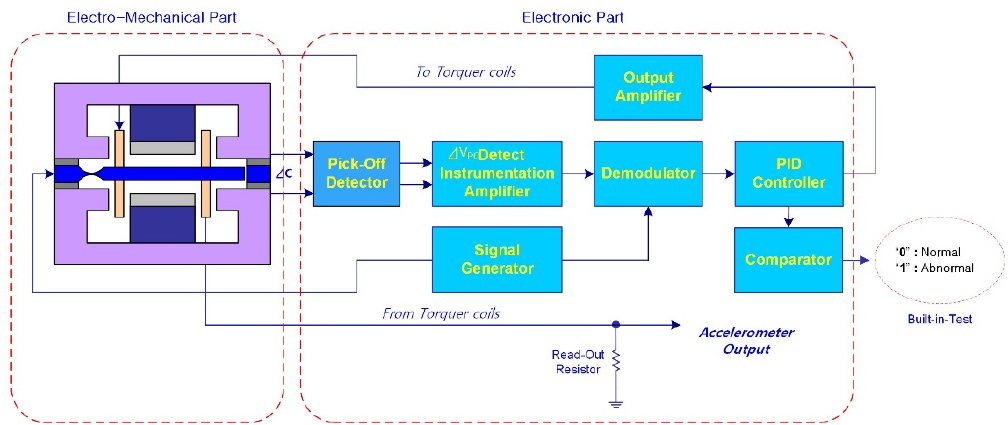
Figure 1. Schematic diagram of an accelerometer structure. An acceleration occurs, the pendulum tries to move in the opposite direction. Electronic rebalance loop makes the pendulum maintain to zero point. Acceleration is measured by the feedback signal. The variation of pendulum characteristics caused by temperature change results in temperature stabilizing error.